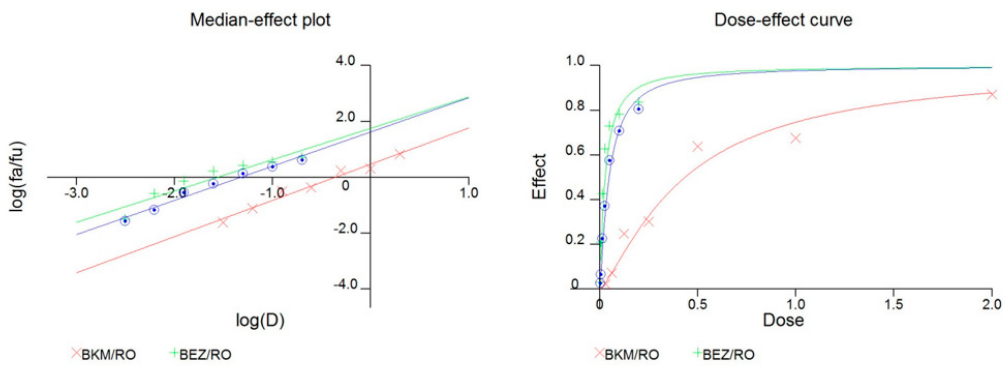
Figure 5. The combination of a GSI and PI3K inhibitor had a synergistic effect on PTEN ‐ mutant GIC. Table 2. Combination Index of GSI and PI3K inhibitor in GICs cells in vitro.